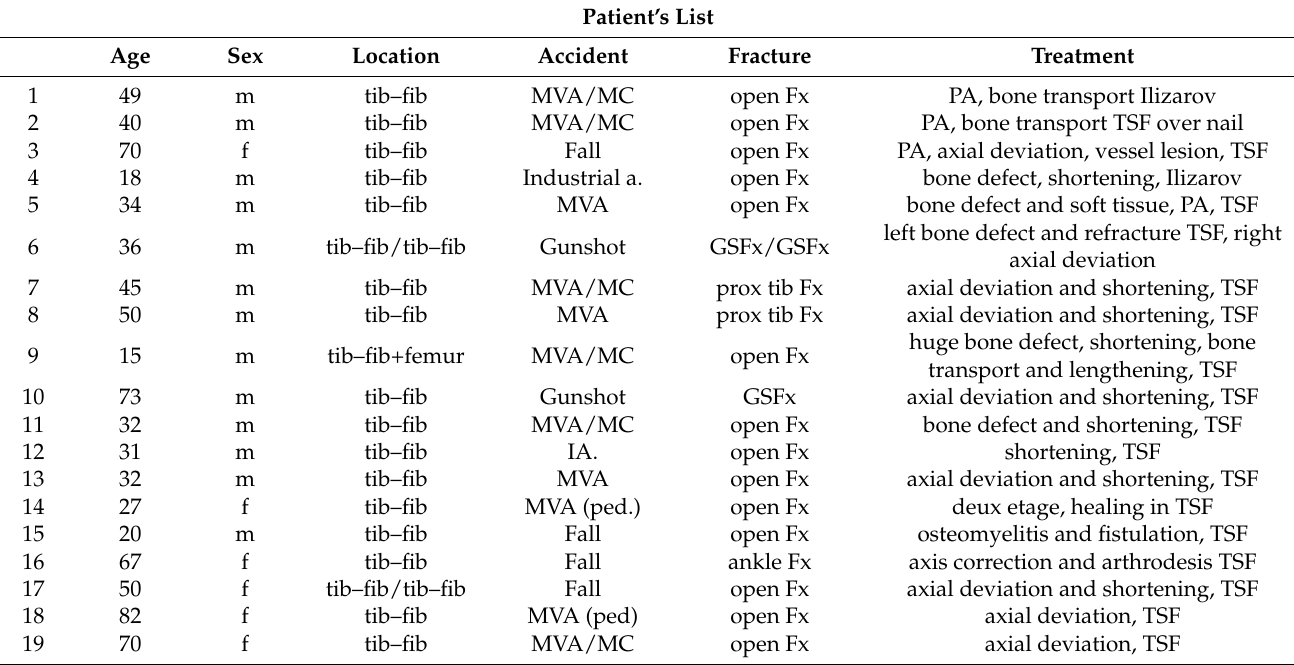
Table 2. List of all patients, including age, gender, location on the lower limb, trauma anamnesis, type of fracture, and treated type of